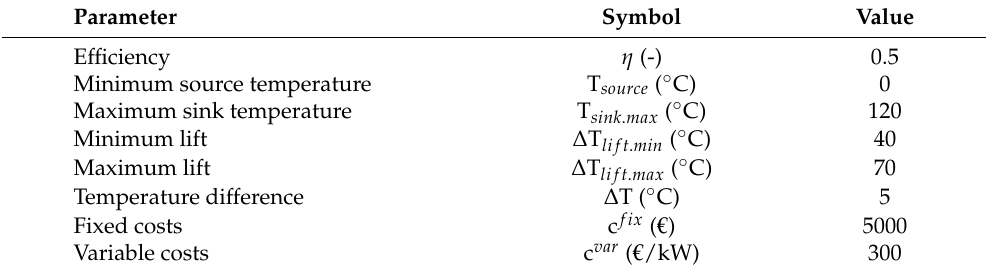
Table 2. Basic data of the HP.